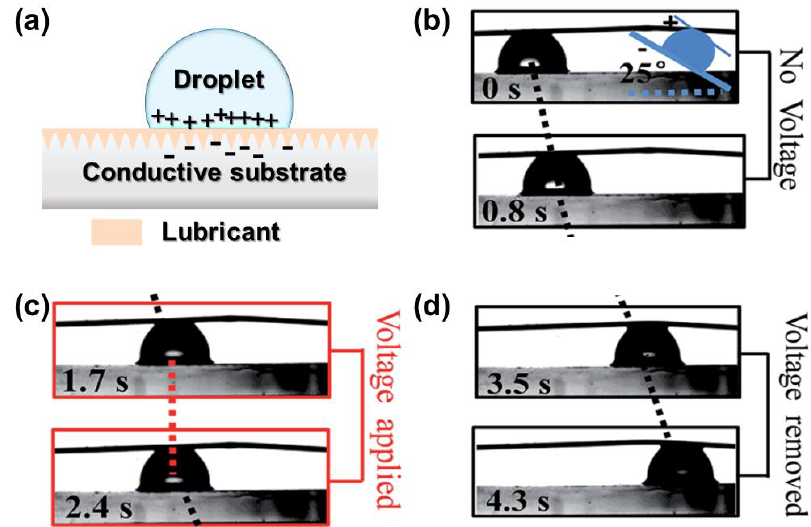
Figure 9. ( a ) Demonstration of the droplet control mechanism on electric-responsive LIS positive charges and negative charges are distributed in conductive droplet and substrate, respectively. ( b ) Water droplet sliding on LIS with oil viscosity of 100 cSt. ( c ) Droplet pinning on LIS when applying 2.4 V. ( d ) Droplet continues to slide after removing the voltage. The LIS sample is tilted at 25°. Reproduced from [62] with permission from The Royal Society of Chemistry.